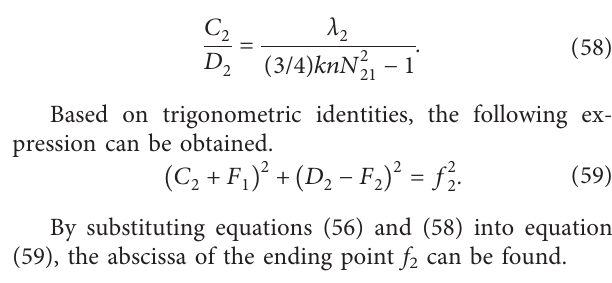
Figure 12: Time-history curves of nonlinear energy sink. The dashed line refers to the steady-state response of the slow-varying equation. � 0 . 8 ; λ � 0 . 3 ; kn � 5 ; f � 0 . System parameters: λ 1 2